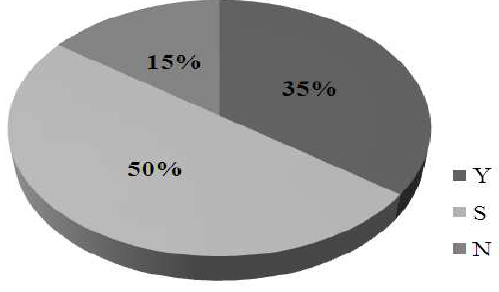
Fig. 13. Experienced personnel